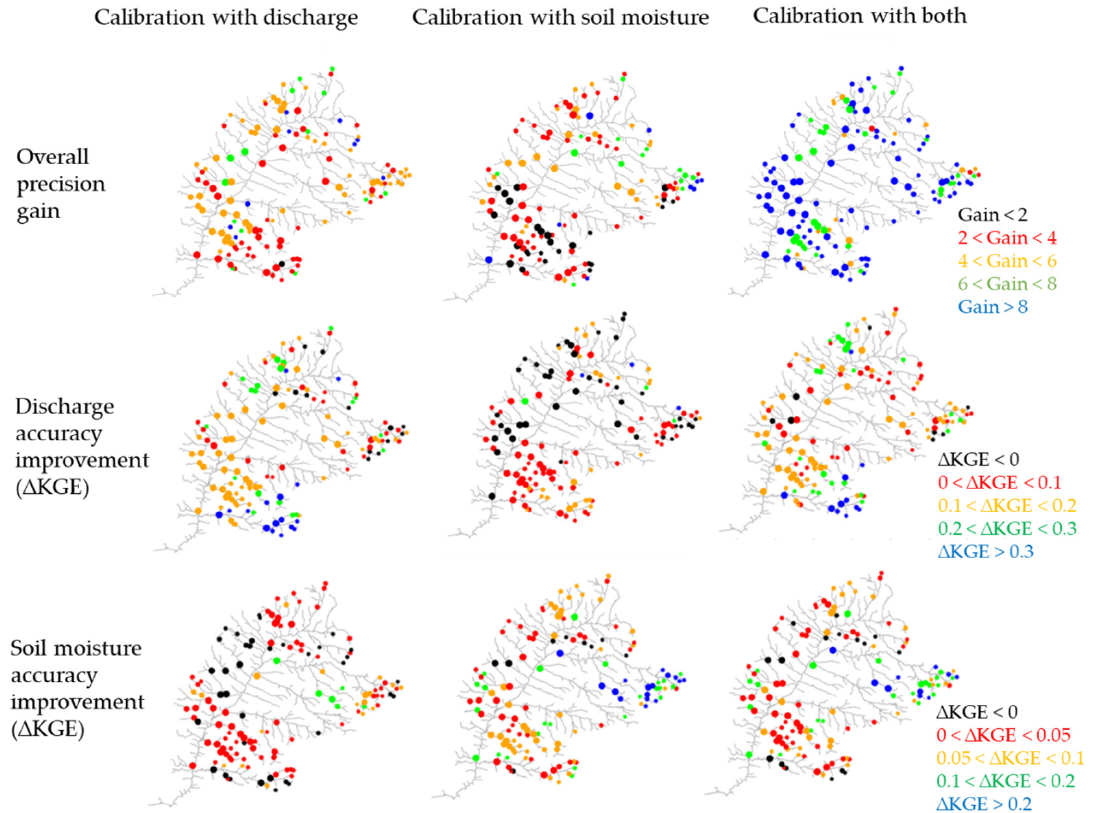
Figure 4. Spatial assessment of 136 gauges for overall performance precision gain (i.e., the joint improvement in precision of soil moisture and discharge) (first row) and accuracy improvement for discharge (second row) and soil moisture (third row) data for the calibration scenarios involving discharge only (first column; CAL-D), soil moisture only (second column; CAL-S), and the combination of both (third row; CAL-DS). The circle size refers to the gauge drainage area, while the maximum circle size is limited for drainage areas > 10,000 km 2 .